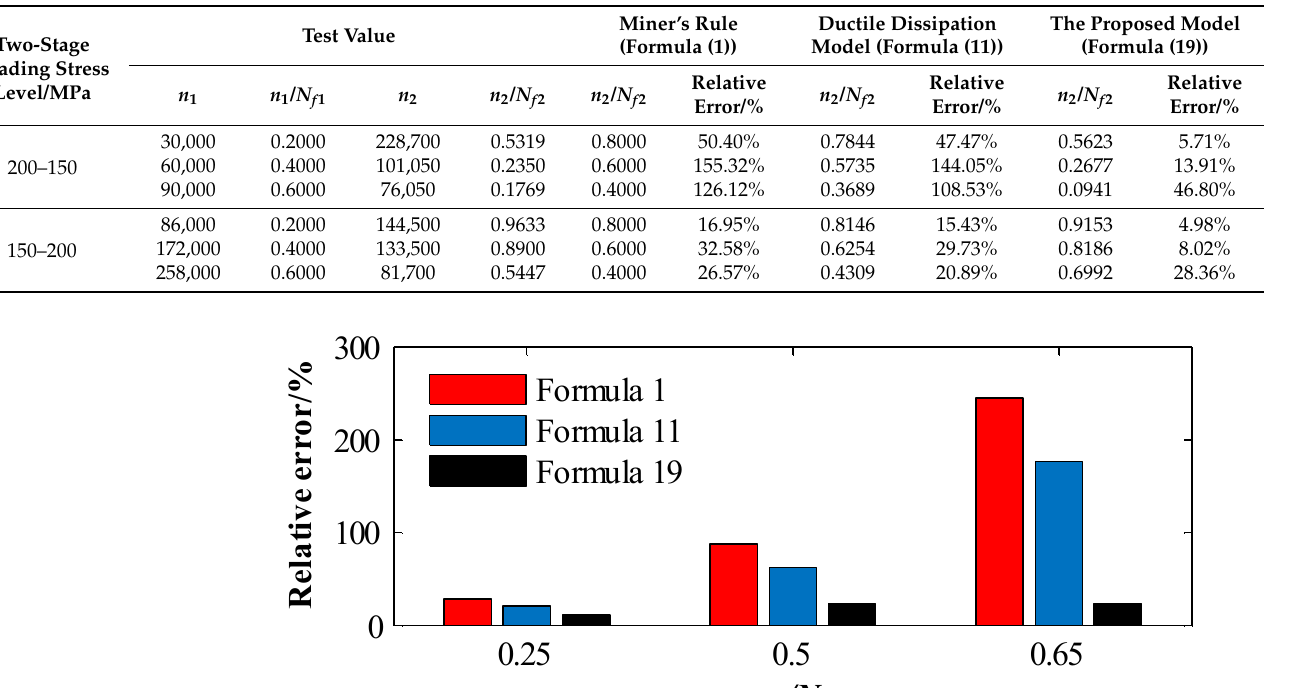
Appl. Sci. 2021 , 11 , x FOR PEER REVIEW